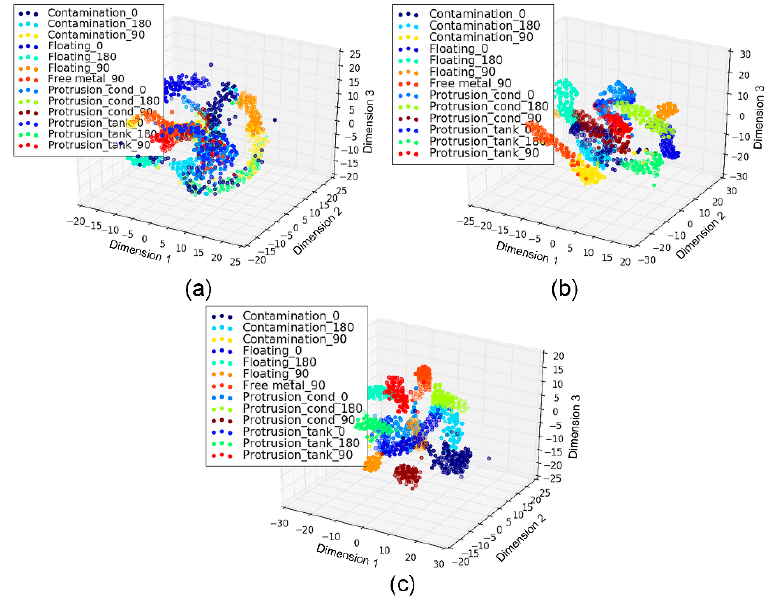
Figure 17. Visualization of the learned features for both the defects and positions: ( a ) Temporal channel; ( b ) frequency channel; ( c ) texture channel.